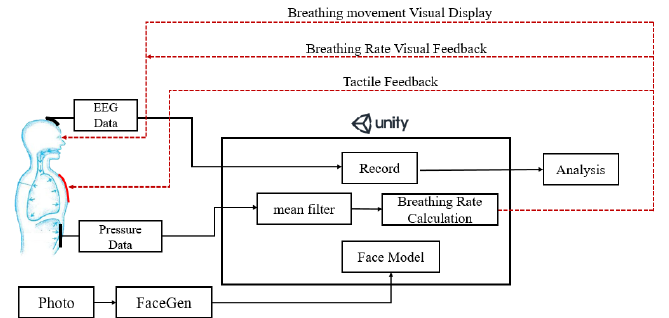
Figure 1. The architecture of the proposed multimodal feedback system.